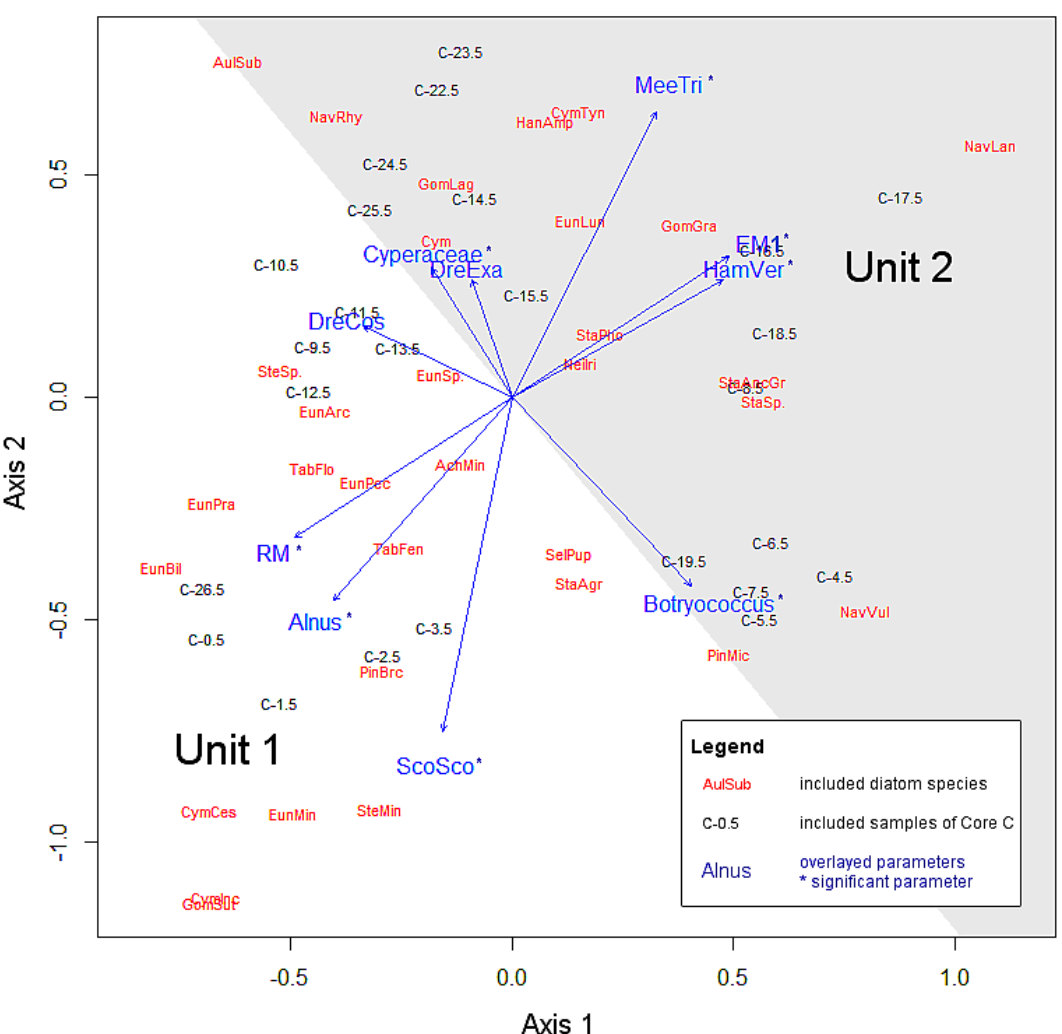
Fig. A7. NMDS plot of the diatom community (excluding the samples at 21.5 and 19.5cm length), overlain by the calculated robust endmem- ber (EM1) and the residual member (RM), together with data on important species of moss, pollen, and non-palynomorphs. For abbreviations of diatom species, see Table